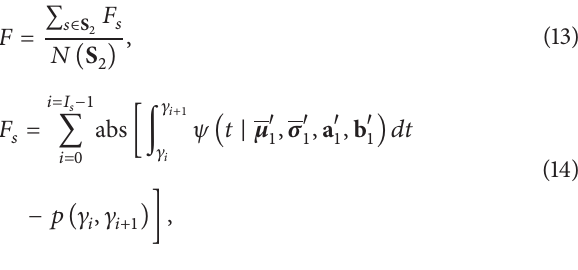
Figure 7: The distribution of the number of OD pairs with only one effective